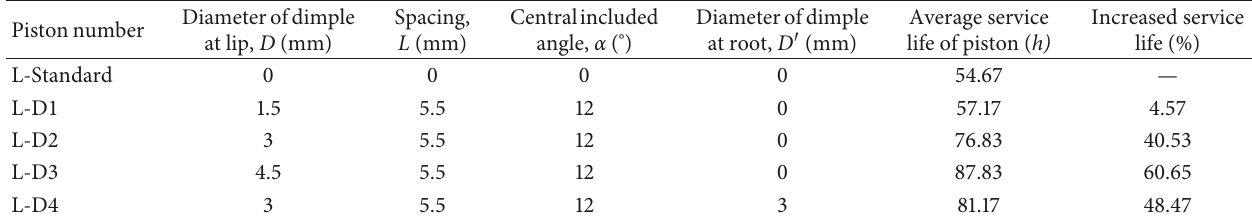
Table 1: Influence of different dimple diameters on piston service life.